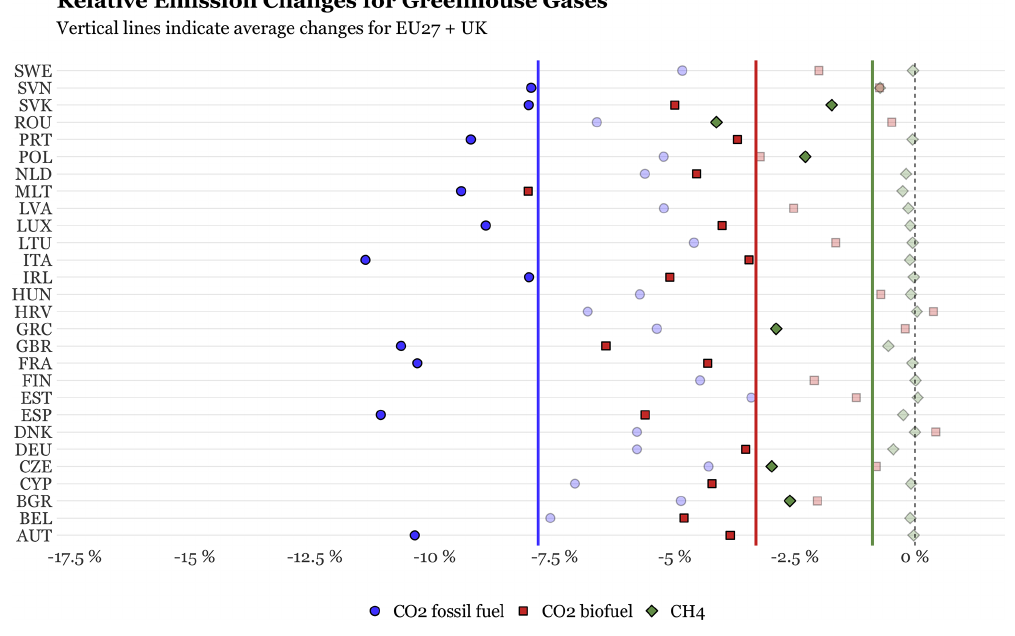
Figure 7. Same as Fig. 6 for greenhouse gases.